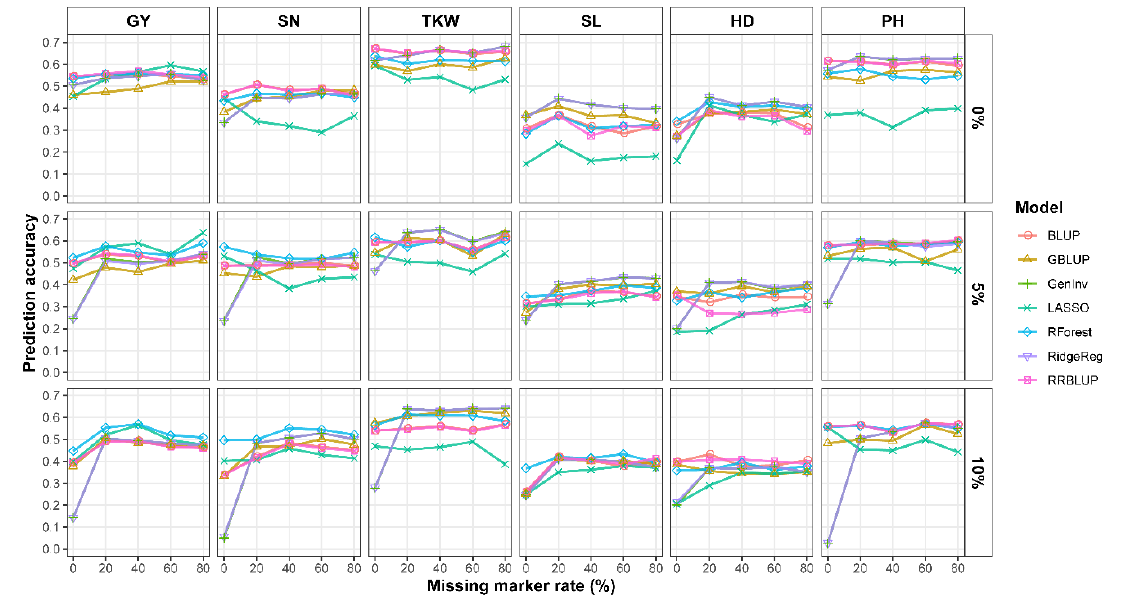
Figure 2. Genomic prediction accuracy of seven genomic selection (GS) models for yield and yield-related traits with five missing rates (columns) and three minor allele frequencies (MAFs) (rows). 0% MAF, represents markers with MAF greater than 0; GY, indicates grain yield; SN, spike number per square meter; TKW, thousand-kernel weight; SL, spike length; HD, heading days; PH, plant height.